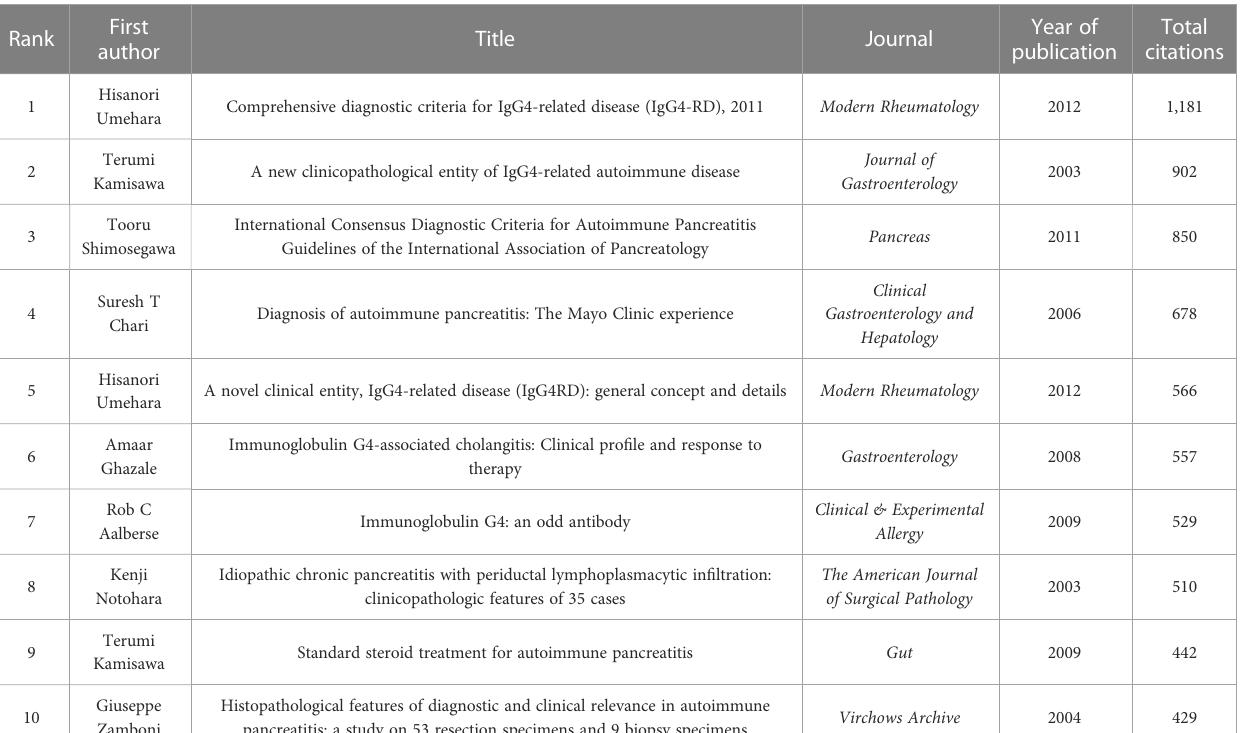
TABLE 5 The top 10 references on AIP with the highest number of citations.